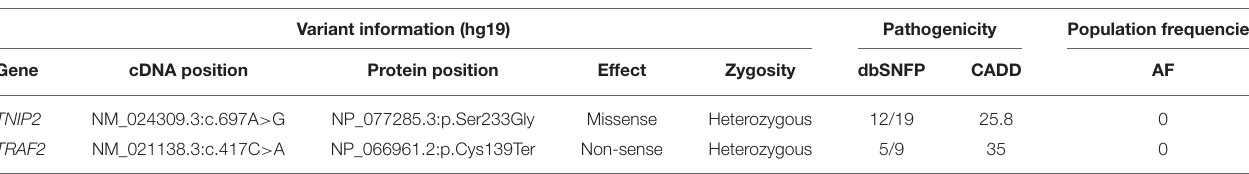
TABLE 2 | Candidate genes and variant in silico